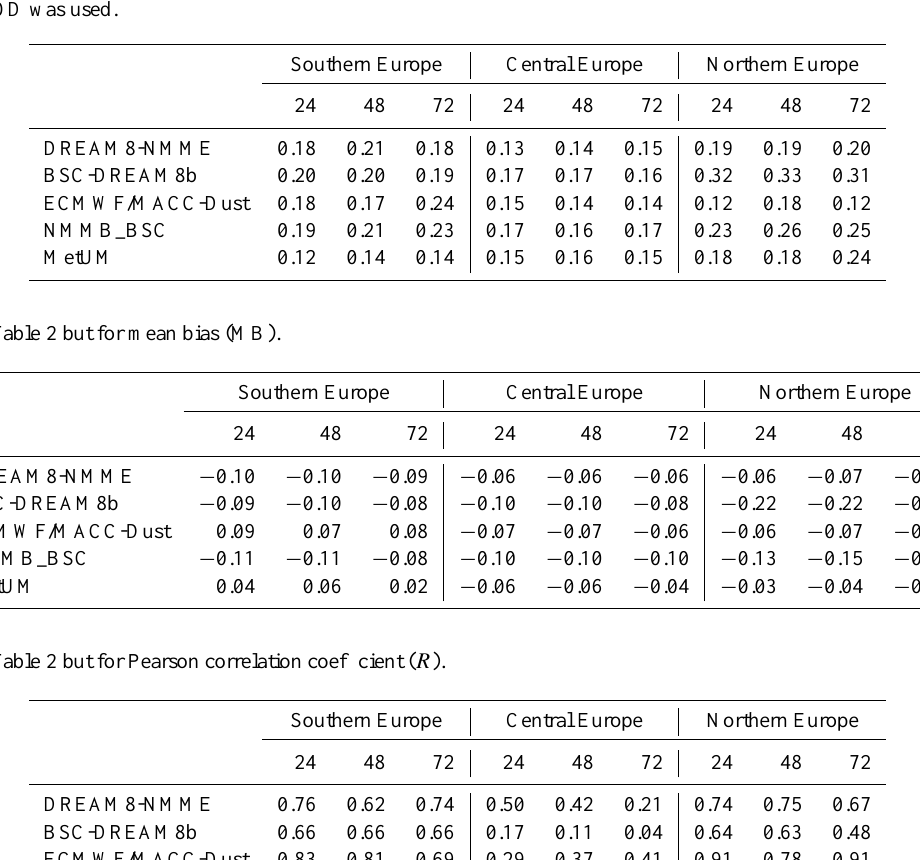
Table 2. Root mean square error (RMSE) quantifying the performance in reproducing AERONET total AOD for each model. The statistics are computed for stations in southern, central and northern Europe (Fig. 1), considering the period between 5 and 11 April. Note that for all models the dust AOD was used.